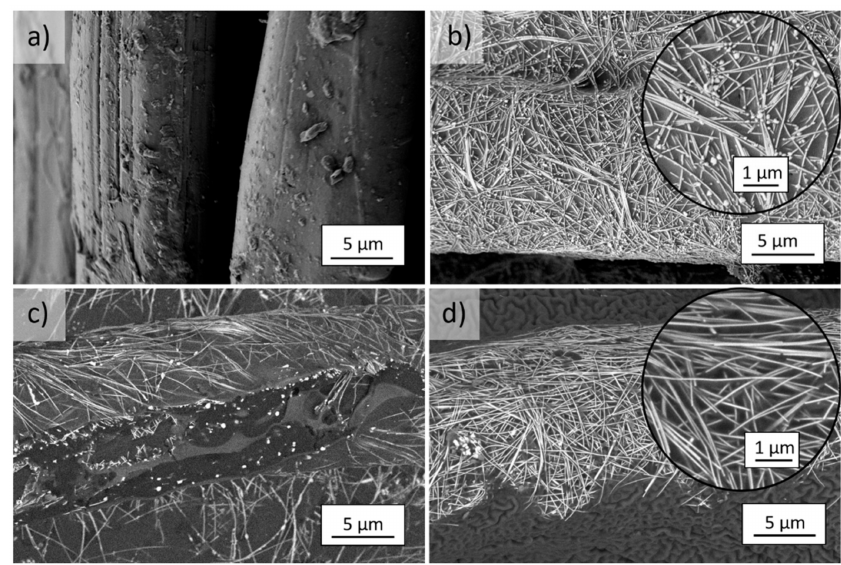
Figure 8. SEM images of UV irradiated (365 nm, 96 h) p Ar fibers ( a ) reference and after ( b ) 5-fold AgNWs application, ( c ) mixture Ag+S, and ( d ) layer-by-layer Ag/S modification (magnification of 6500 × and 20,000 × ).